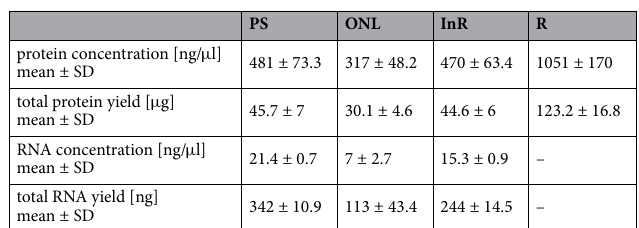
total RNA yield [ng] mean ± SD Table 1. Protein and RNA yields from PS, ONL, and InR samples obtained from flat-mounted half-retina (R) prepared with the ReLayS method.